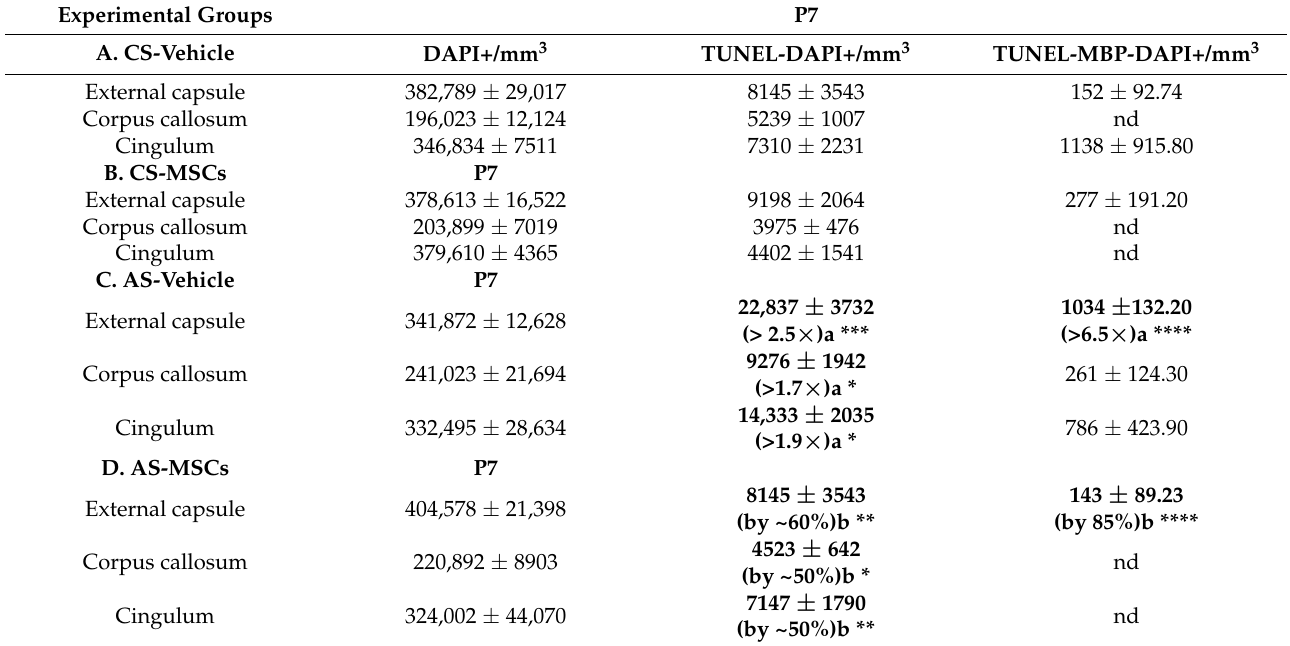
Table 5. Effect of perinatal asphyxia (PA) on apoptotic-like (TUNEL-DAPI/mm 3 ) and OLs-specific (TUNEL-MBP-DAPI/mm 3 ) cell death in telencephalon from control (CS) and asphyxia-exposed (AS) rats at P7: Effect of neonatal MSCs treatment. Coronal sections of telencephalon were treated for immunohistochemistry against TUNEL, and MBP, counterstained with DAPI. Microphotographs (two-five samples per brain region) were taken from external capsule, corpus callosum, and cingulum, in the field of a confocal-inverted Olympus-fv10i microscope at 60 × . The means of DAPI positive cells per mm 3 , alone; colocalizing with TUNEL/mm 3 , and MBP- TUNEL/mm 3 were estimated using ImageJ software. Data are shown as means ± S.E.M from at least n = 5 independent experiments. No statistically significant difference was observed in DAPI per mm 3 in any of the evaluated regions (external capsule F(2, 17) = 2.477, p = 0.114); corpus callosum (F(2, 17) = 3.279, p = 0.662); and cingulum (F(2, 17) = 1.257, p = 0.310). Unbalanced two-way ANOVA indicated a significant effect of PA on TUNEL-DAPI/mm 3 , increased in external capsule (>2.5), corpus callosum (>1.7 × ), and cingulum (>1.9 × ) of AS vehicle versus CS vehicle animals (a), but decreased significantly in external capsule (F(2, 17) = 10.430, p < 0.001);